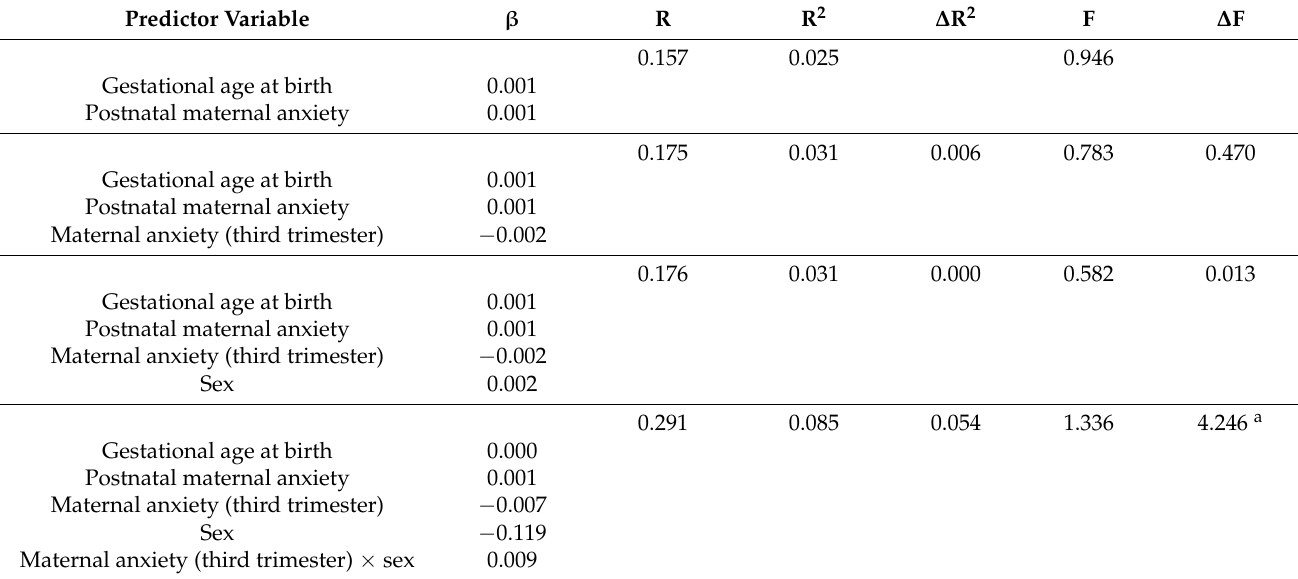
Table 3. Linear regression model of methylation level of IGF2/H19 -CpG1.